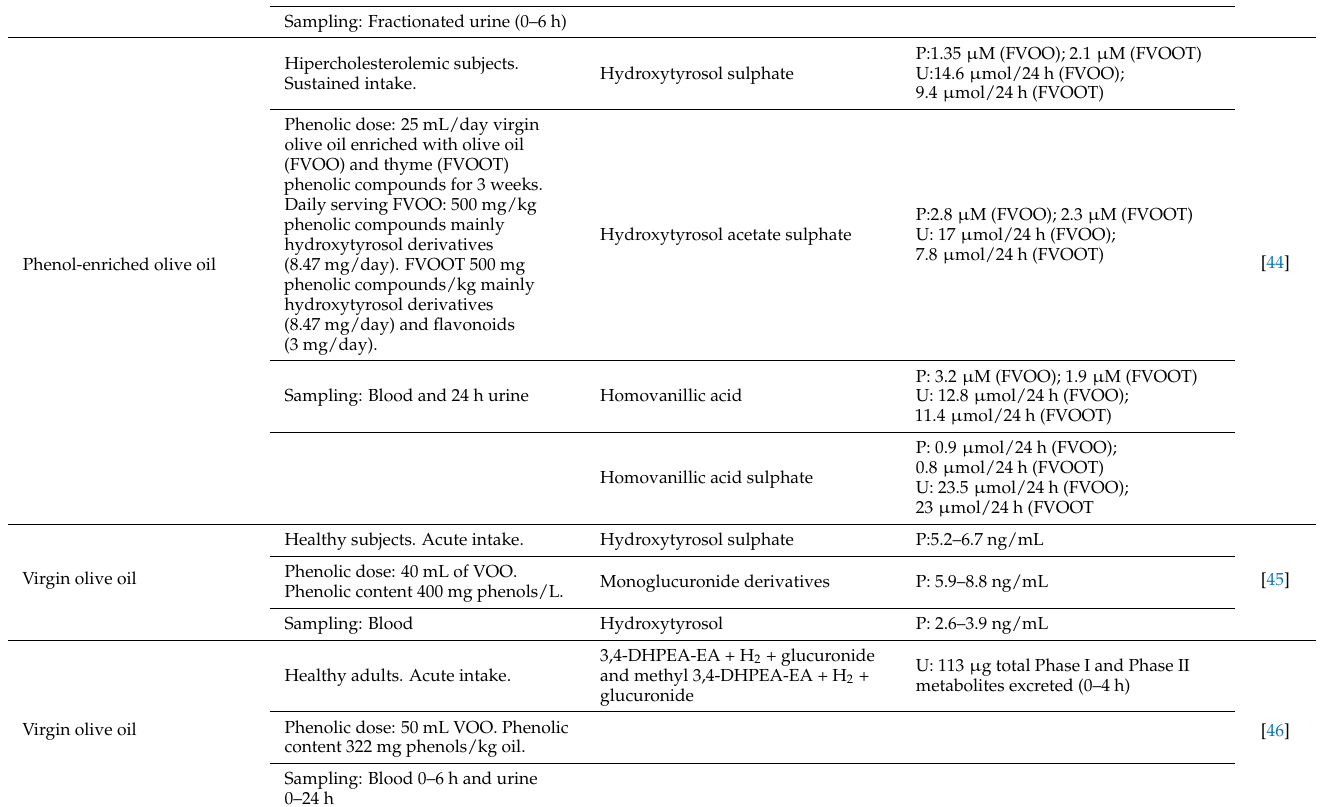
Phenol-enriched olive